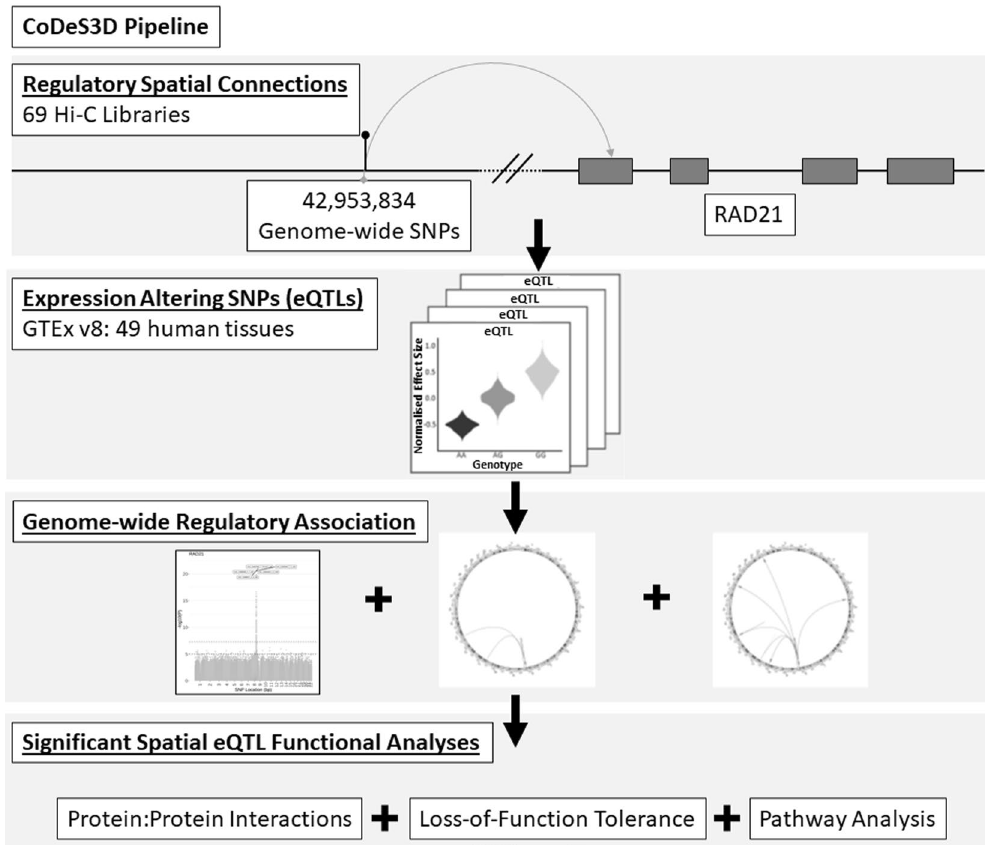
Figure 4. Schematic representation of the research